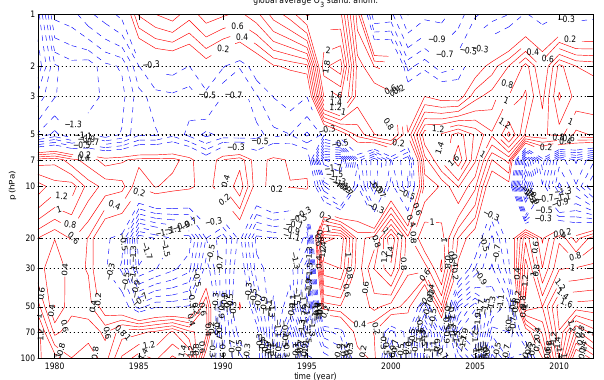
Figure 2. Latitude–pressure cross section of the slope of the linear trend for (a) O 3 and (b) T annual standardized anomaly. Shaded areas denote statistically significant trends at the 95% confidence level. Units for trends are per year.